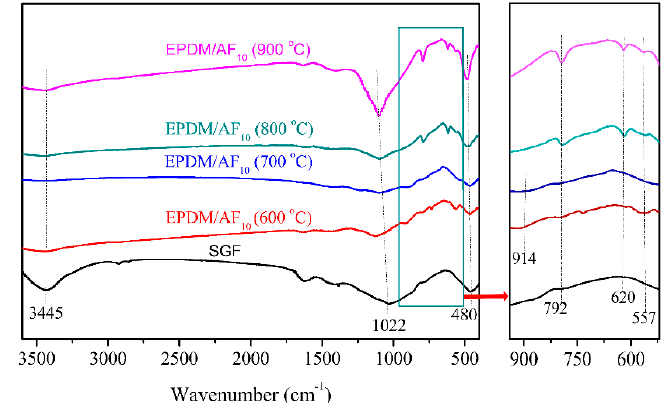
Figure 10. FTIR spectra of silicate glass frits (SGF) and residues of EPDM/AF 10 fired at different temperatures.